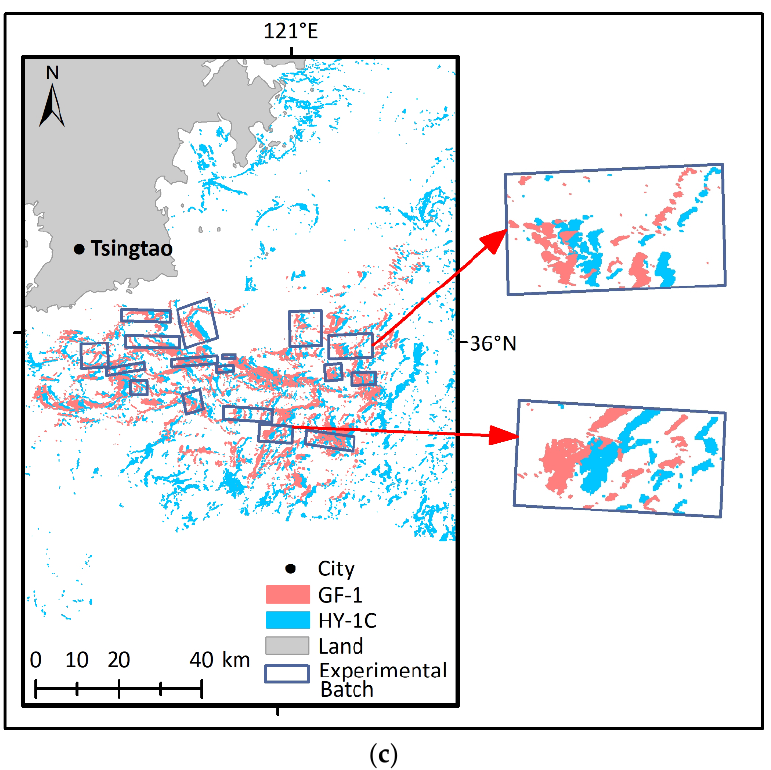
Figure 4. Experimental patch distribution for M HG establishment and verification. ( a ) Distribution of modeling patches on 20 June 2021. ( b ) Distribution of verifying patches on 25 May 2021. ( c ) Distribution of verifying patches on 21 July 2021.